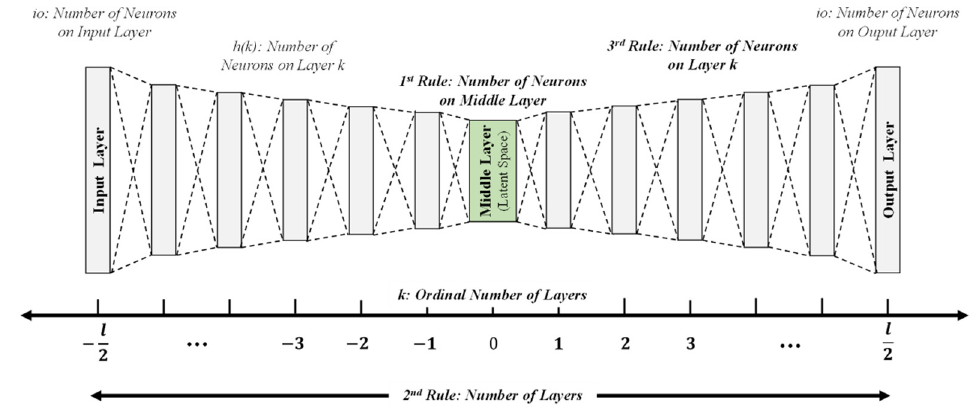
Figure 8. Rules for semantic topology of the autoencoder.